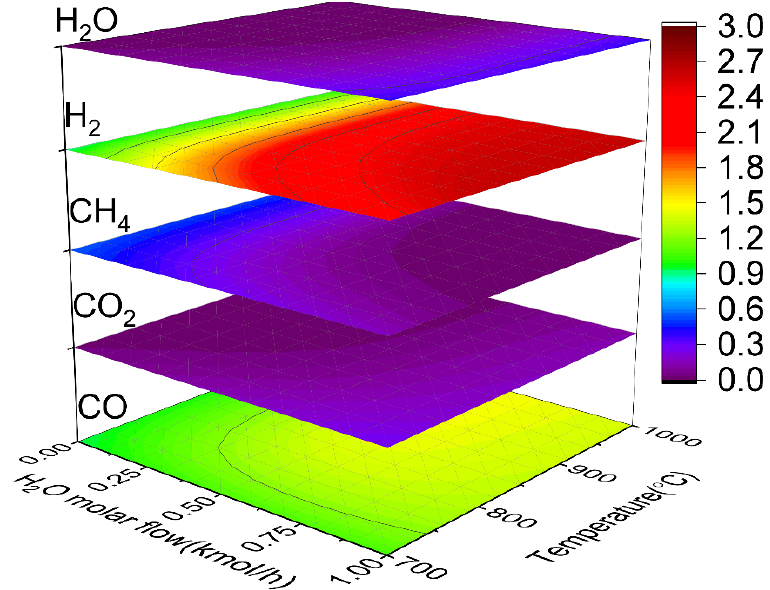
Figure 4. Effects of H 2 O flowrate and temperature on gaseous products.